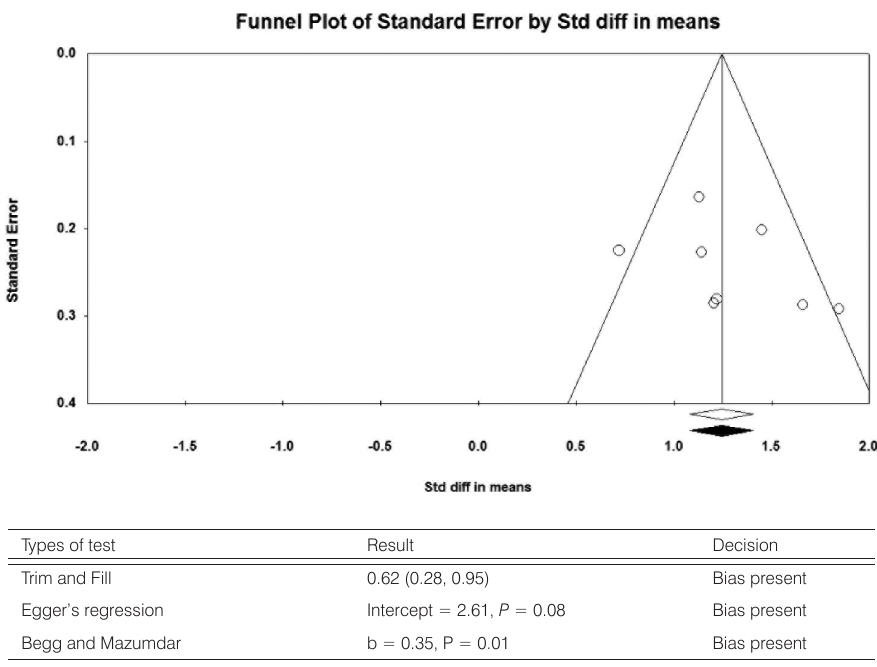
Figure 4. Funnel plot showing publication bias among included